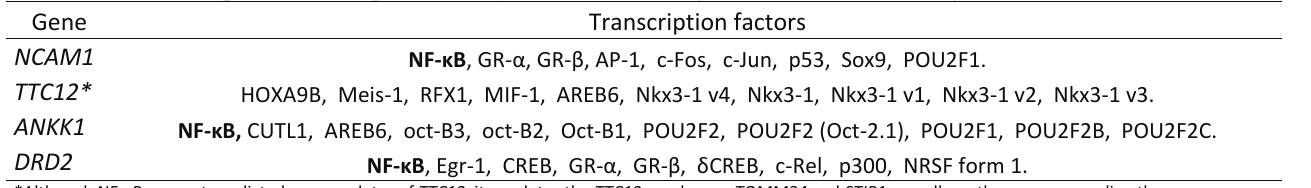
Table S2. Transcription factors predicted by DECODE as regulators of the NTAD genes in humans.